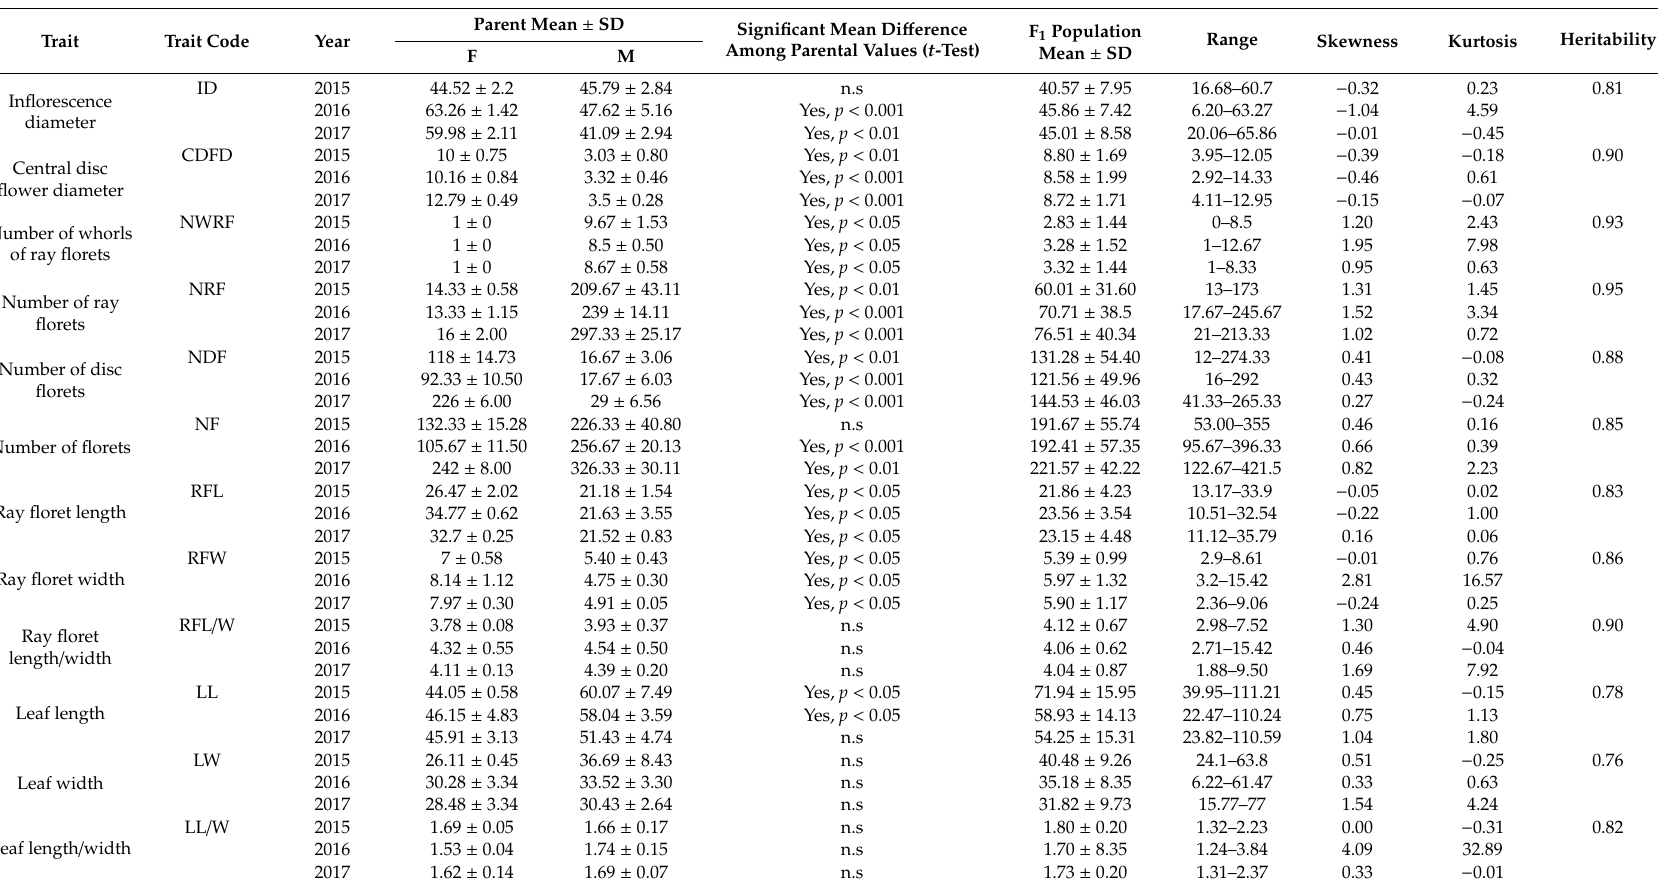
Table 3. Parent mean ( ± SD) and population mean ( ± SD) and range for 12 inflorescence and leaf traits. Skewness and kurtosis ( ± SE) and values of broad-sense heritability for 12 traits are also